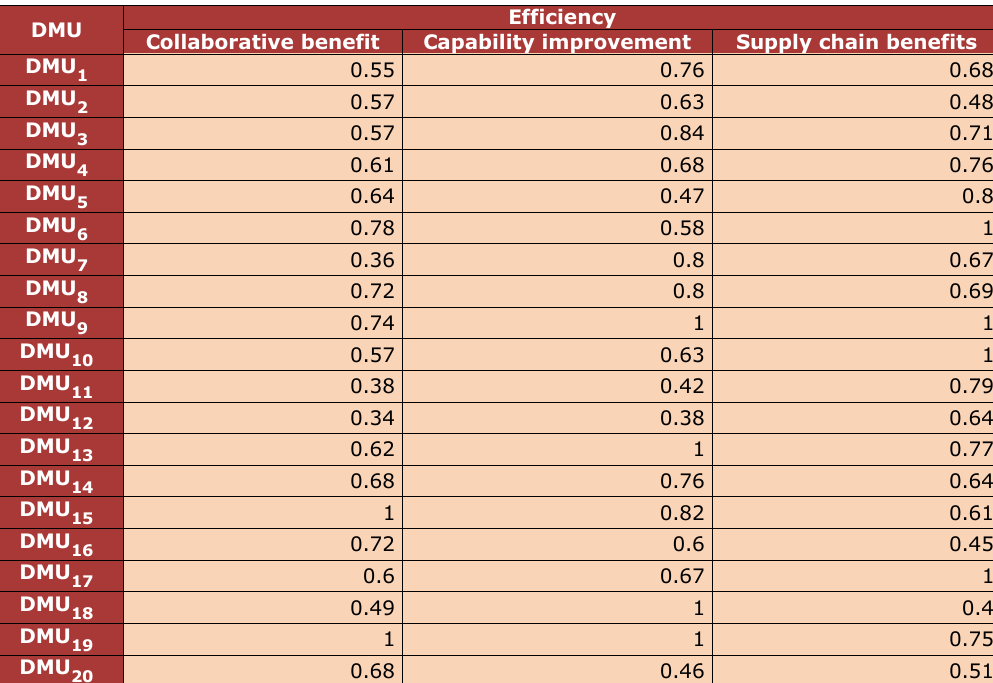
Table 2. Dimensions and criteria of the evaluating system in 2014